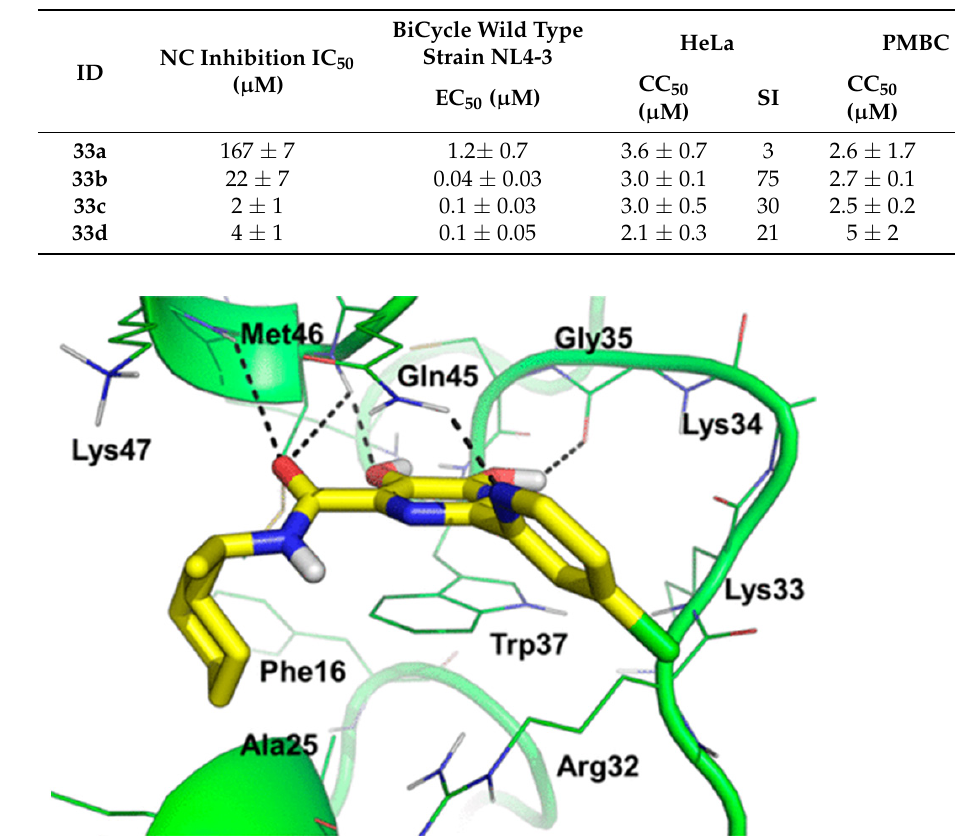
Table 5. The inhibiting activity of analogs 33 against HIV nucleocapsid and cells [38].